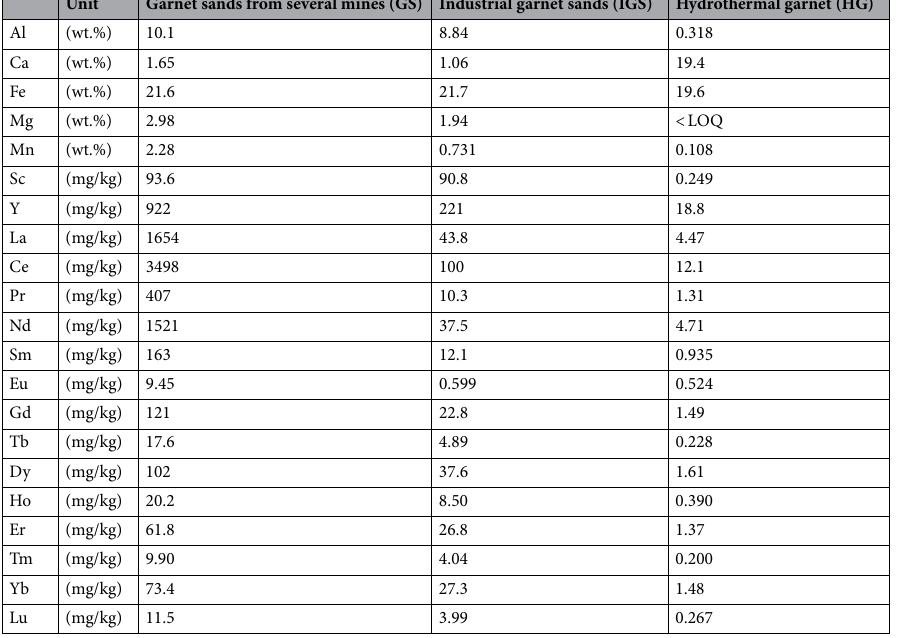
Table 1. Average major element concentrations (wt.%) and REY and Sc concentrations (mg/kg) of GS, IGS and